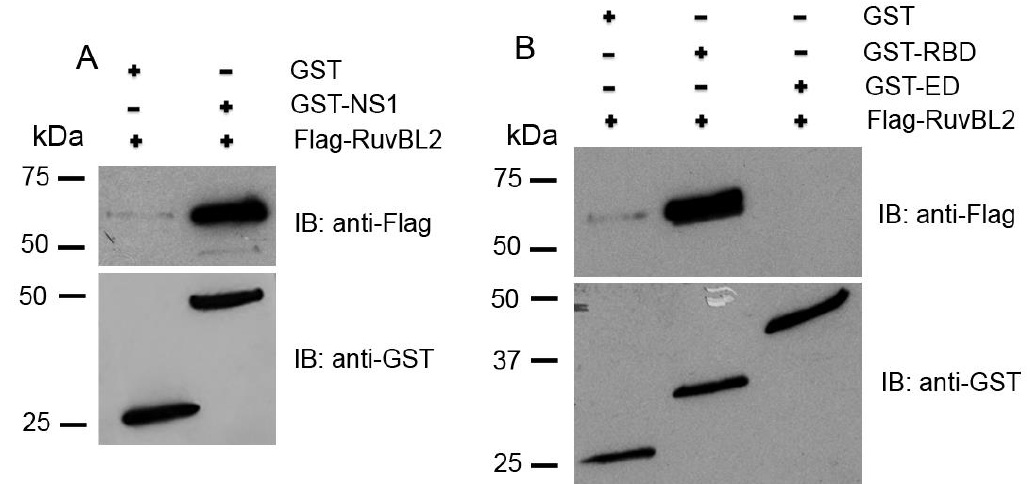
Figure 4. RuvBL2 binds the RBD domain of the NS1 protein. ( A ) RuvBL2 physically binds the full-length NS1. ( B ) RuvBL2 physically binds the RBD domain of the NS1. Purified GST, GST tagged full-length NS1, GST-ED, or GST-RBD was incubated with equal molar amounts of purified Flag-RuvBL2, followed by pulldown by glutathione beads. The bound proteins were analyzed by Western blotting.